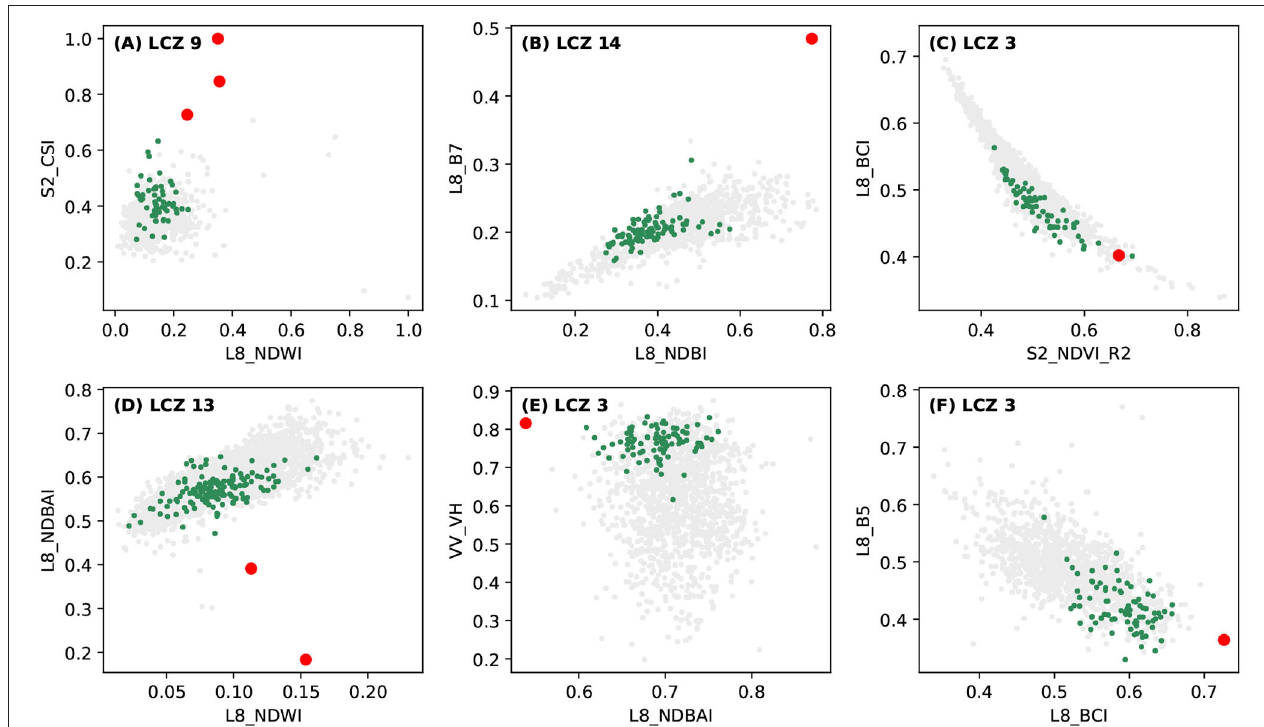
FIGURE 12 | Spectral values for all pixels in one LCZ class, corresponding to the subplots of Figure 11 (gray dots). Pixels flagged as outliers by DBSCAN are shown in red. Remaining pixels from the pixel’s parent polygon are shown in